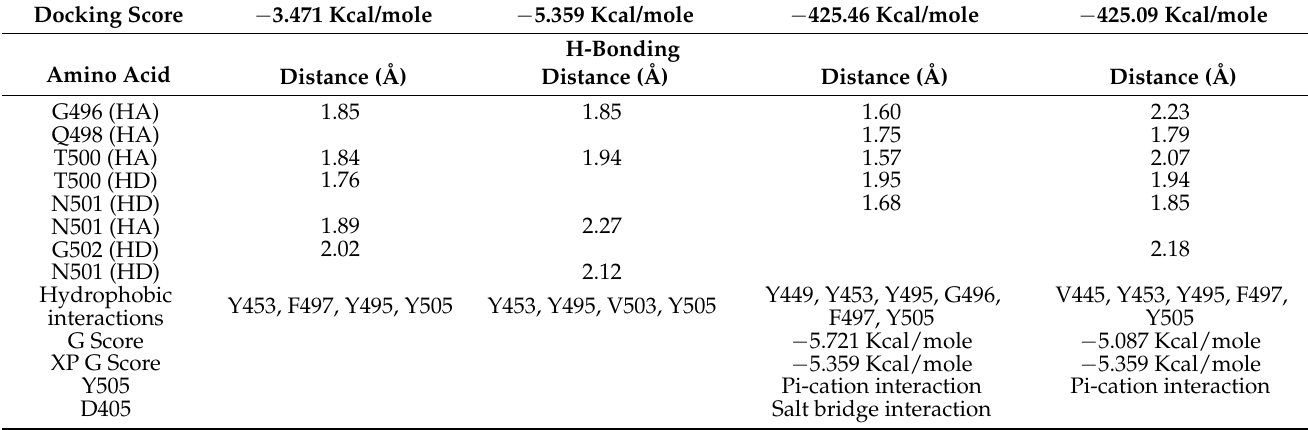
Figure 5. ( A ) COVID-19 bilayer final structure snapshot with k21. ( B ) The spike interaction site with ACE-2 ( C , D ). The induced fit pose 4 ( A , B ) docking active ligand with Glide during the k21/QA docking step. ( E ) The induced fit pose 5 according to Glide Score. Table 1. Docking scores, docked structures, and fit poses of the k21/QA drug formulation used for screening with